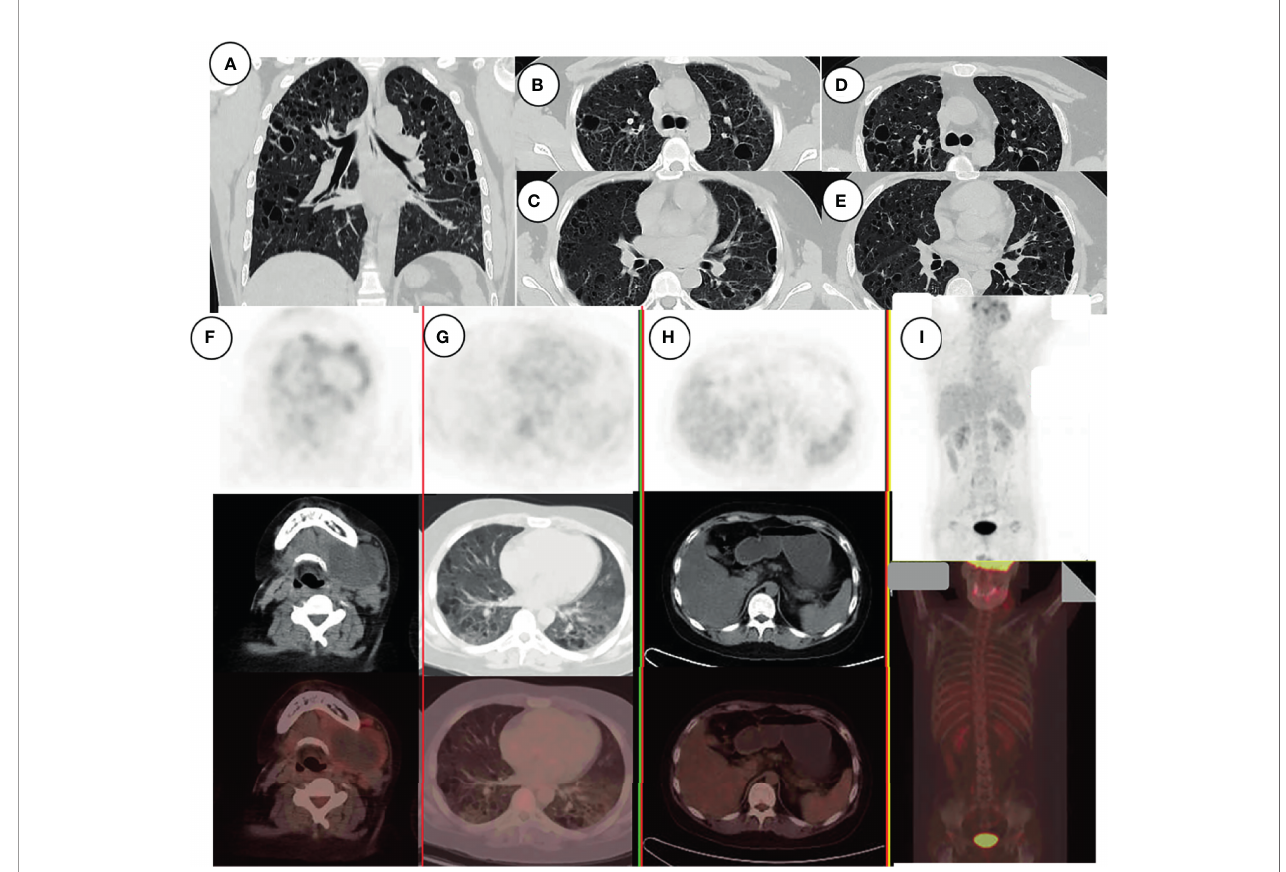
FIGURE 3 | HRCT of the chest, showing numerous variably sized pulmonary cysts that were con fl uent in some places (A – C) ; the cysts became larger and thin- walled after chemotherapy (D, E) . PET-CT examination of the patient ’ s general condition. Signal from the left neck mass and multiple small lymph nodes (F) , pulmonary cystic lesions (G) , and liver (H) . There was no signal from bone (I)